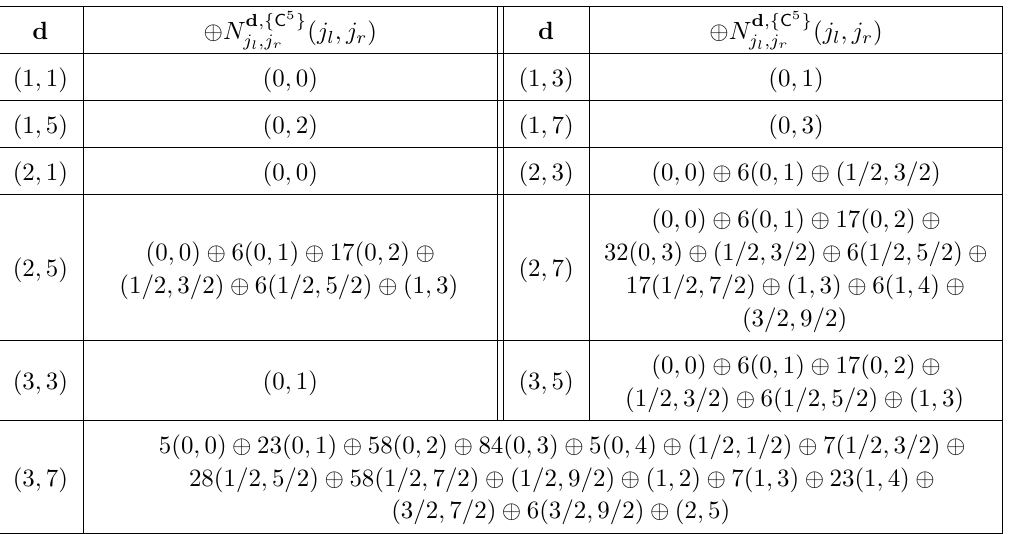
Table 9 . BPS Spectrum of the BPS sector F and d 2 ≤ 7